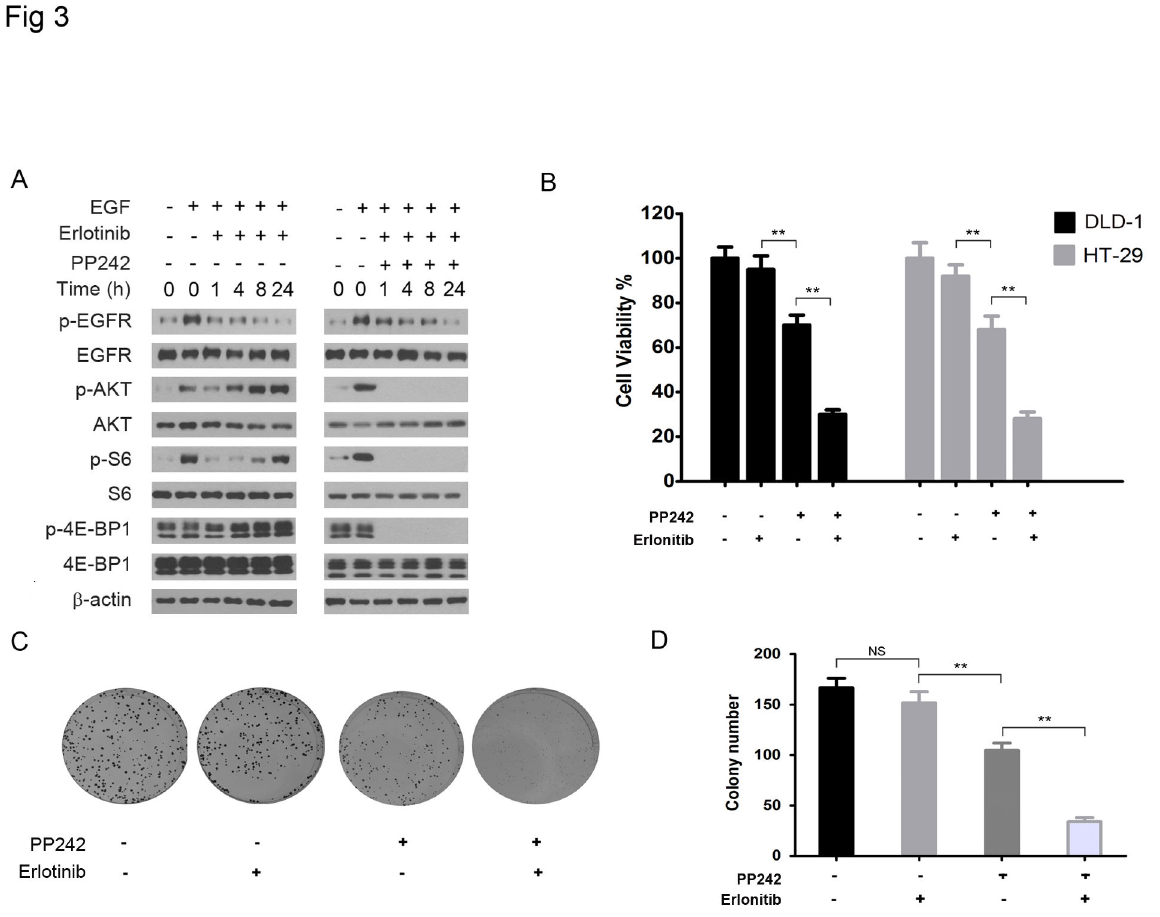
Figure 3. The combination of P242 and erlotinib inhibits the carcinoma cell growth. (A) DLD-1 cells grown in EGF (50 ng/ml) containing medium were treated with erlotinib (2 μM) and PP242 (1 μM), alone or in combination, for the indicated hours and analyzed by western blotting for the indicated proteins ( left ). (B) DLD-1 and HT29 cells were treated with PP242 (1 μM) and erlotinib (2 μM), alone or in combination, and then subjected to cell viability assay. The data were presented as mean + SD. **, p < 0.01. (C) Colony formation assay of DLD-1 cells, treated or untreated with PP242 (1 μM) and/or erlotinib (2 μM), shows the colony densities in culture wells. (D) The colony numbers from the colony formation assay as described above in C were accounted and presented as mean + SD. NS, no significance; **, p <